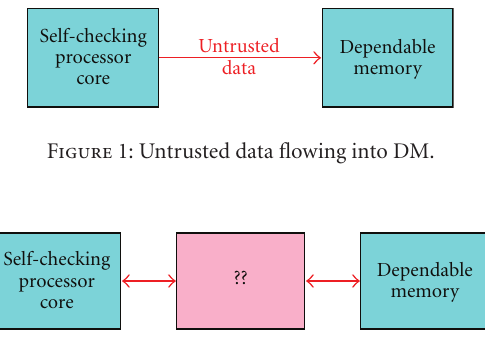
Figure 2: Principle of the overall organization